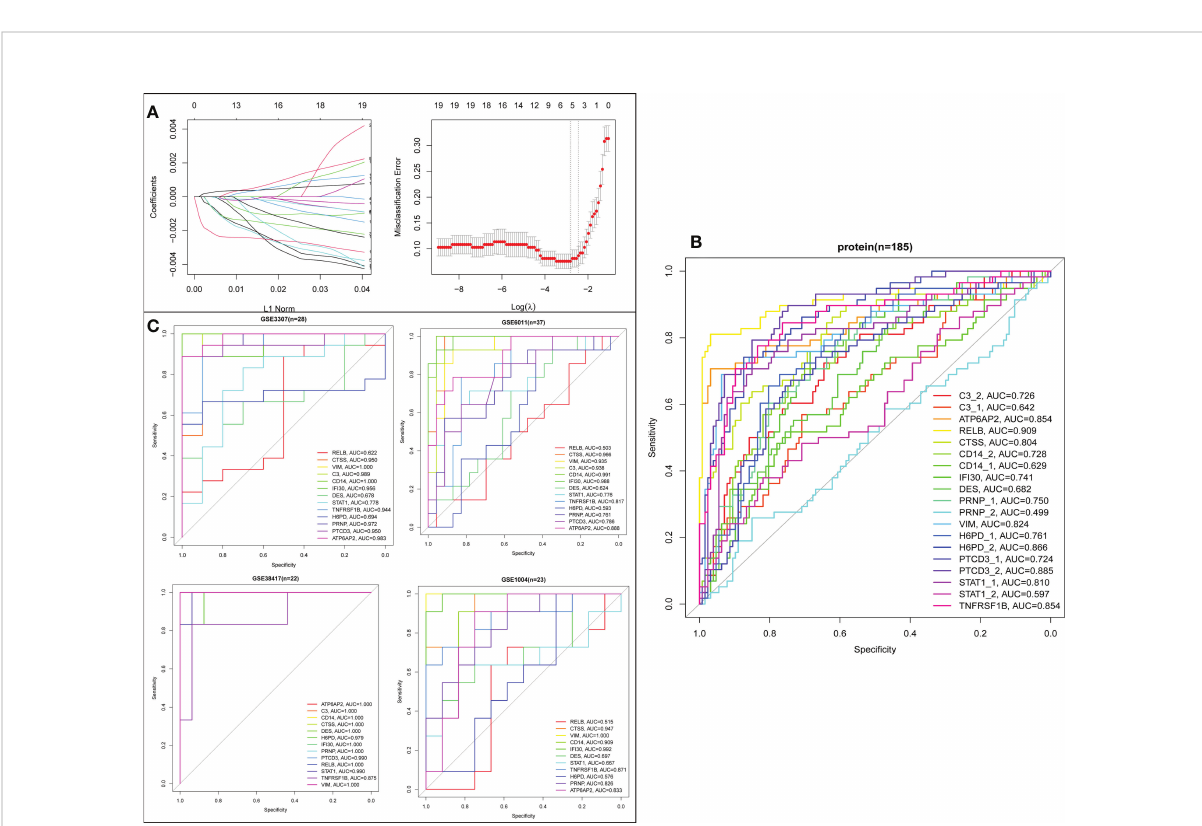
FIGURE 11 Screening process of the biomarkers for DMD. (A) LASSO coef fi cient pro fi les of the 19 proteins. (B) ROC curve evaluation of the diagnostic effectiveness of the 19 potential biomarkers in protein dataset (n=185). (C) ROC curve evaluation of the diagnostic effectiveness of the 19 potential biomarkers in four mRNA